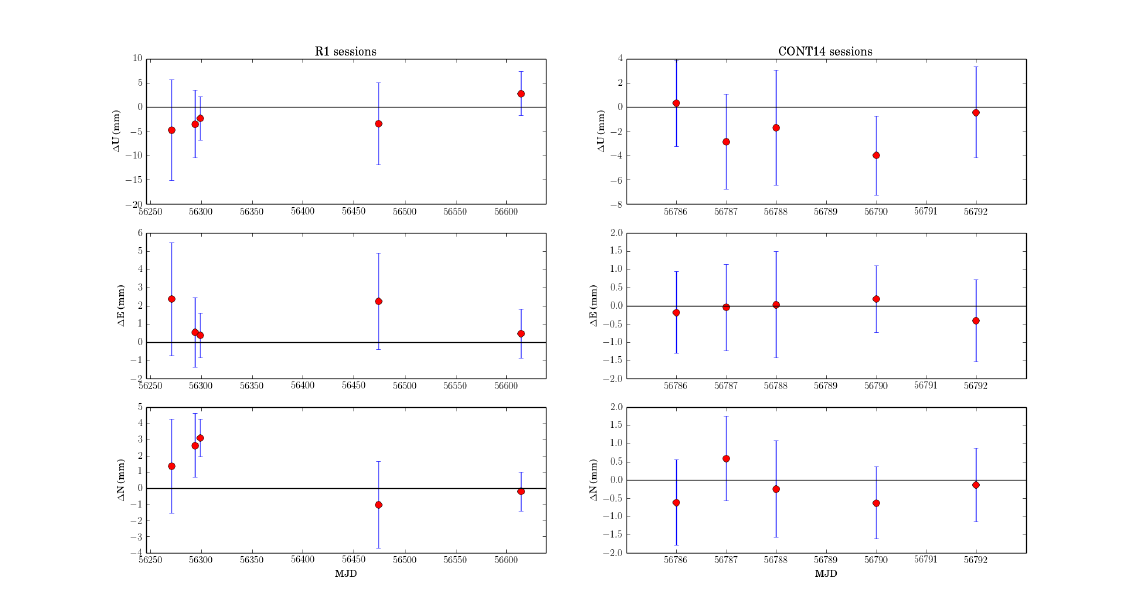
Figure 6: Onsala station position differences in up (top row), east (middle row), and north (bottom row) from IVS-R1 (left column) and CONT14 sessions (right column).